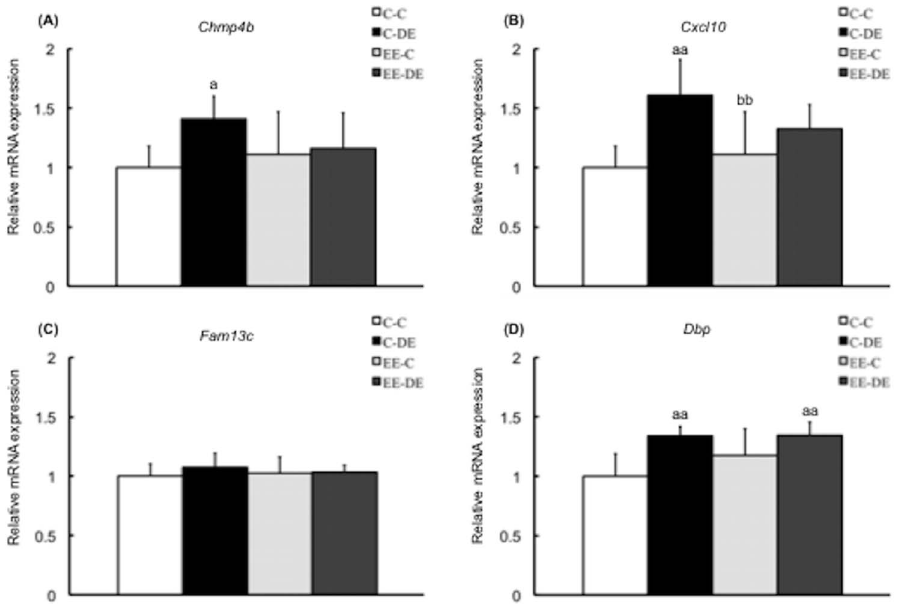
Figure 4. Confirmation of microarray data in cluster A by RT-PCR. Data show mRNA expressions for (A) Chmp4b , (B) Cxcl10 , (C) Fam13c , and (D) Dbp in the olfactory bulb of mice in each group. Chmp4b , Cxcl10 , and Dbp , except for Fam13c , of mice reared in a standard cage environment were significantly upregulated by exposure to diesel exhaust. There was no significant effect of exposure to diesel exhaust on gene expressions of mice reared in environmental enrichment. The data are expressed as relative target gene expression compared with Gapdh expression. Each column represents the mean 6 standard deviation (C-C: n=7, C-DE: n=7, EE-C: n=8, EE-DE: n=9). Data were analyzed by two-way analysis of variance as described in the Methods section. An analysis of simple effects is as follows: Chmp4b : a indicates significant differences (Tukey–Kramer method, a P , 0.05, C-C vs. C-DE); Cxcl10 : a indicates significant differences (Tukey–Kramer method, aa P , 0.01, C-C vs. C-DE); b indicates significant differences (Tukey–Kramer method, bb P , 0.01, C-DE vs. EE-C); and Dbp : a indicates significant differences (Tukey–Kramer method, aa P , 0.01, C-C vs. C-DE and C-C vs. EE-DE).